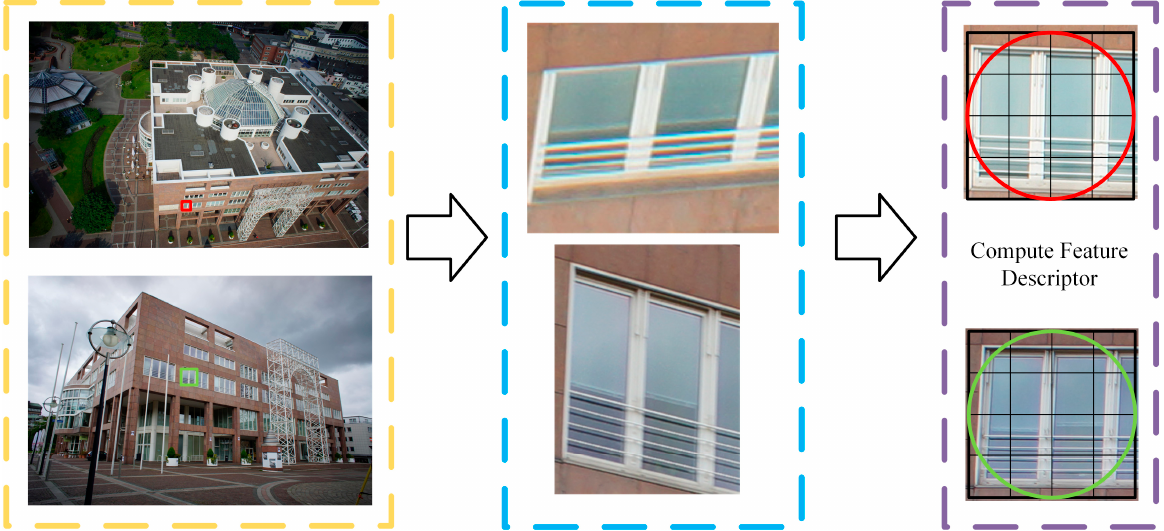
Figure 5. The effect of patch optimization. The yellow area shows the original images, the blue area shows the reprojections of the patches on the original images, and the purple area shows the rectified images on the patches.